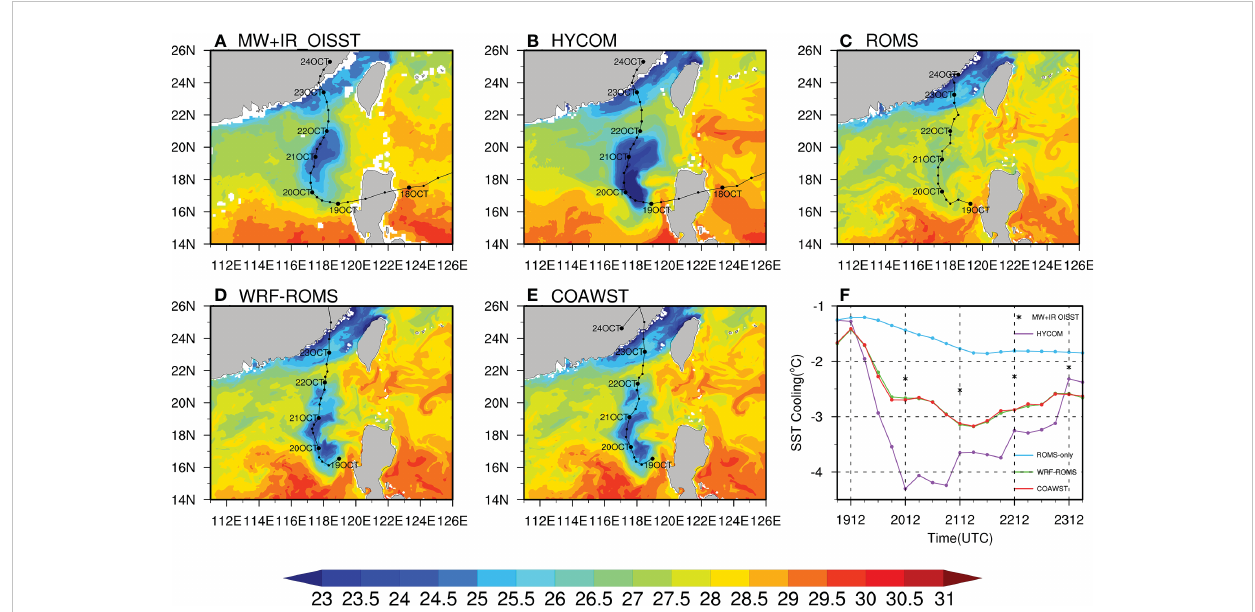
FIGURE 3 (A, B) Observed SST (units: °C) from MW+IR OISST, HYCOM reanalysis and (C – E) simulated SST from different experiments at 18 UTC 22 Oct. The track in (A, B) is derived from CMA best track data, (C) is derived from ERA5 reanalysis, and (D, E) is derived from its own simulation. (F) Observed and simulated average SST cooling of the cold wake. The corresponding values from MW+IR OISST are marked with black asterisks because of the daily interval of